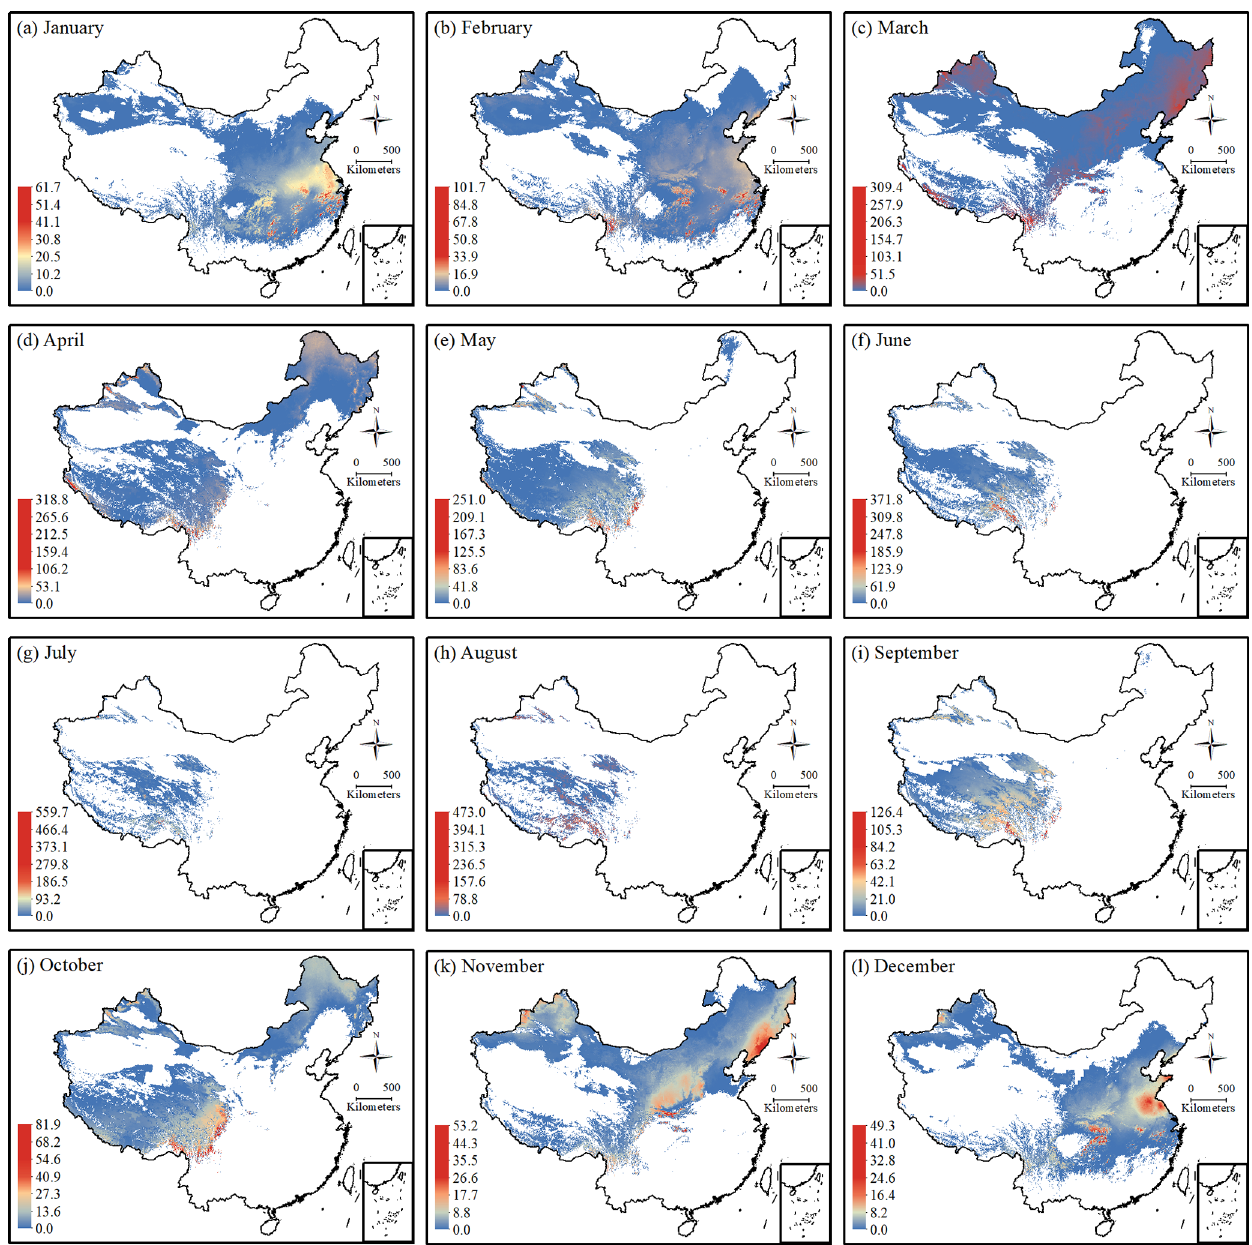
Figure 8. Spatial distribution of the mean monthly snowmelt (millimeters) for 12 months in China during the 1951–2017